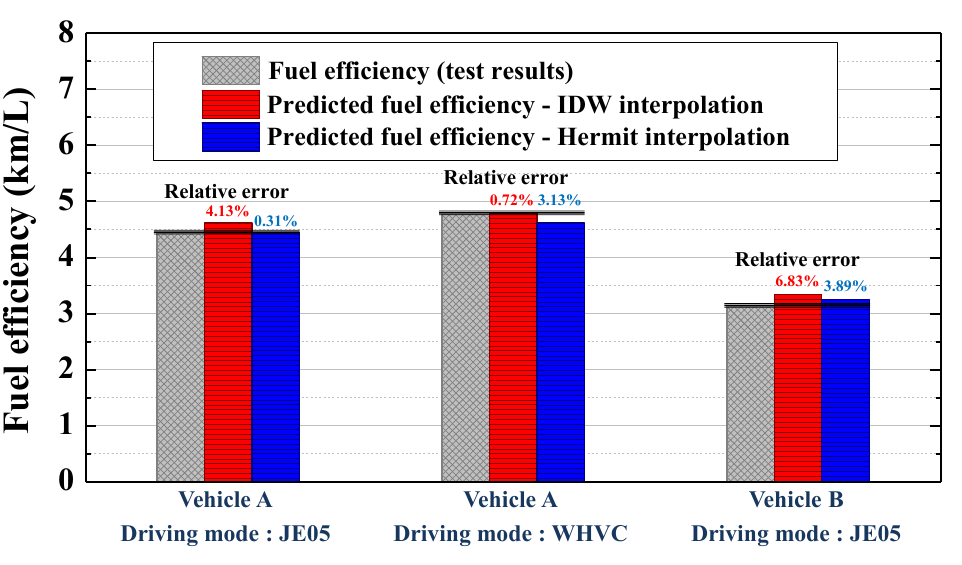
Figure 8. Comparative analysis of the HDV test and predicted fuel efficiency